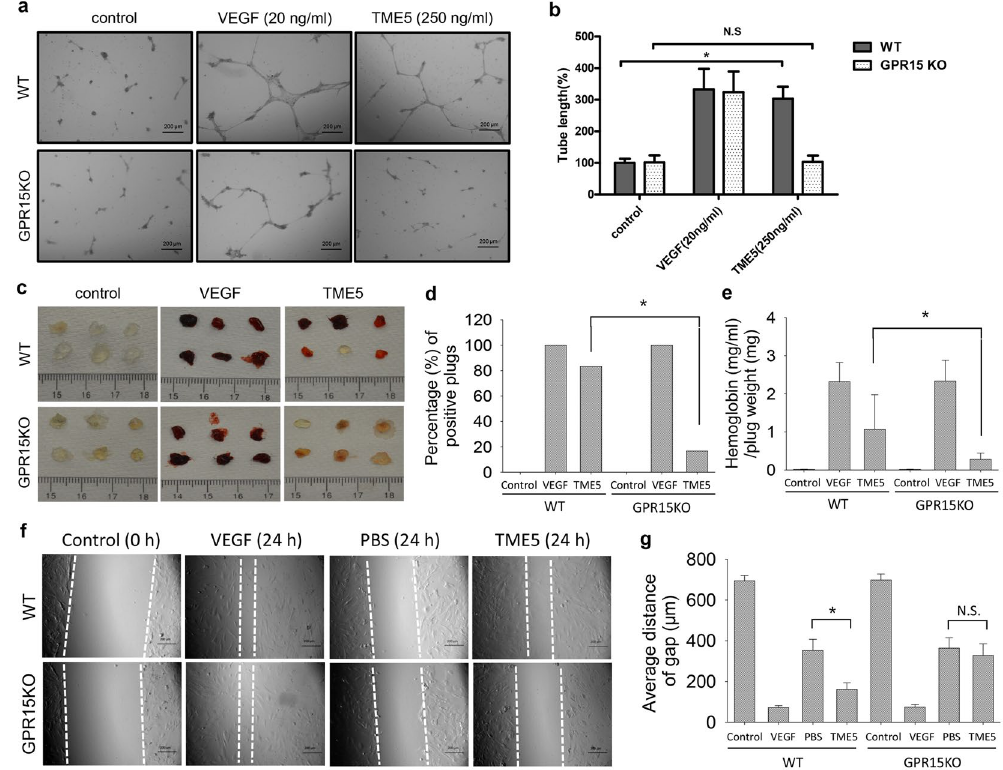
Figure 3. TME5 stimulates angiogenesis of murine ECs in a GPR15-dependent manner. ( a ) In vitro vascular tube formation assays. WT (n = 3) or GPR15 KO (n = 3) ECs were plated into a growth factor-reduced Matrigel-precoated 24-well plate and incubated with control diluent, TME5 (250 ng/ml) or VEGF (20 ng/ml). After an 8-hour incubation, the endothelial cell-derived tube-like structure was visualized under an inverted microscope. Figure represents one from three independent experiments. ( b ) The tube length in 3 randomly chosen fields from each well was measured using NIH ImageJ software and normalized to control. ( c ) In vivo angiogenesis assays. Growth factor-reduced Matrigel (0.5 ml), containing heparin (40 U/ml), with control diluent, TME5 (250 ng/ml) or VEGF (20 ng/ml) was subcutaneously injected into WT (n = 6) or GPR15 KO (n = 6) mice near the abdominal midline. Five days after injection, mice were euthanized, and the Matrigel plugs were surgically removed. ( d ) Frequencies of positive plugs were expressed as percentage and were compared by using chi-square test. ( e ) Matrigel plugs were weighted and were homogenized in 1 ml distilled water on ice. Supernatants were mixed with Drabkin’s reagent, followed by measurement at 540 nm (n = 6). Methemoglobin was used to create a standard curve. ( f ) Murine ECs were scratched with a 1-ml pipette tip. After being rinsed with warm PBS, plates were supplied with DMEM (5% FBS) medium, containing VEGF (20 ng/ml), PBS or TME5 (250 ng/ml). Plates were photographed at 0 h and 24 h after scratch. ( g ) Average distance of the gaps were calculated from 6 random areas of the scratch. Data are shown as mean ± SD, and are compared using one-way ANOVA test. * p < 0.05; N.S., no